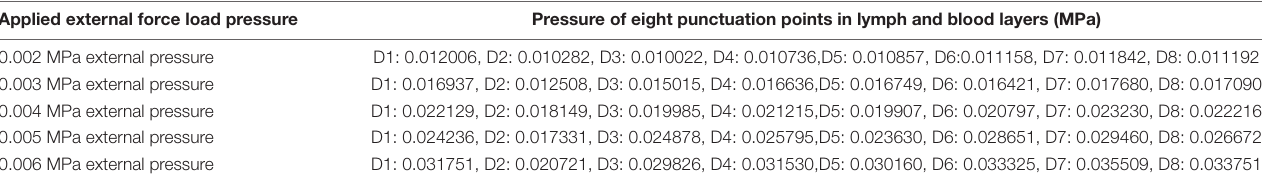
TABLE 4 | Eight-point-specific pressure table of lymph and blood layers of the upper arm model with different external force pressure values. Applied external force load pressure Pressure of eight punctuation points in lymph and blood layers (MPa)